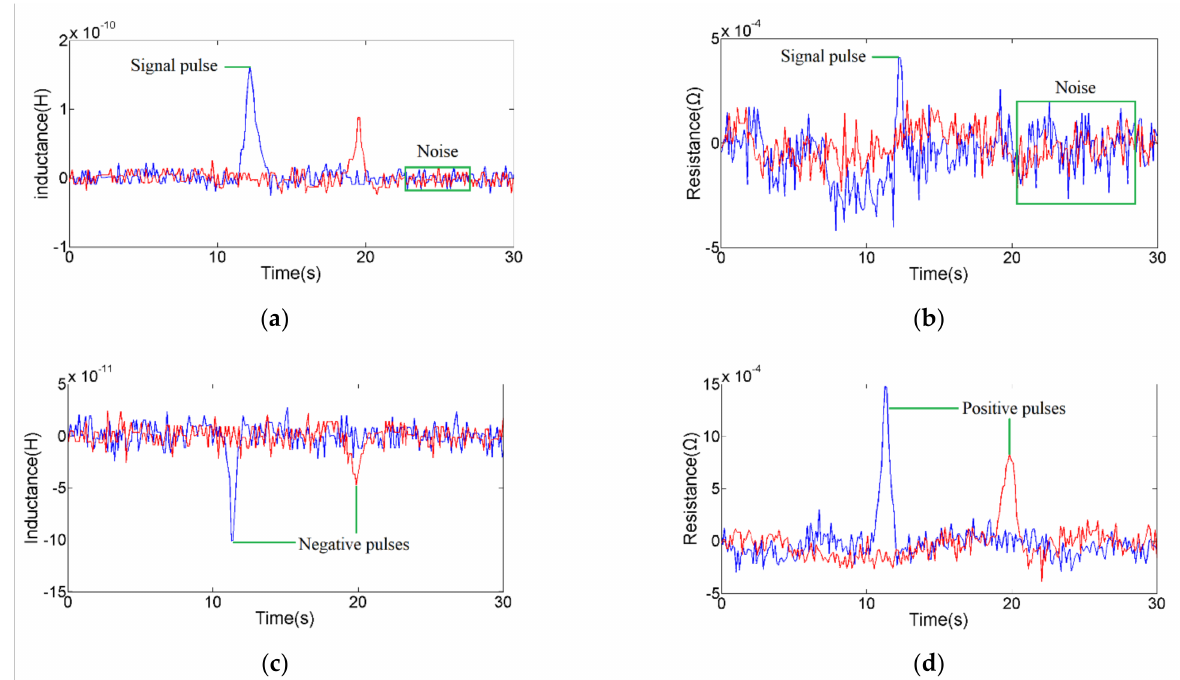
Figure 5. Detection results of coils in parallel; red signal is the result of the sensing unit without silicon steel strips, blue signal is the result of the sensing unit with silicon steel strips: ( a ) inductance pulse of 93 µ m iron particle; ( b ) resistance pulse of 93 µ m iron particle; ( c ) inductance pulse of 186 µ m copper particle; ( d ) resistance pulse of 186 µ m copper particle.